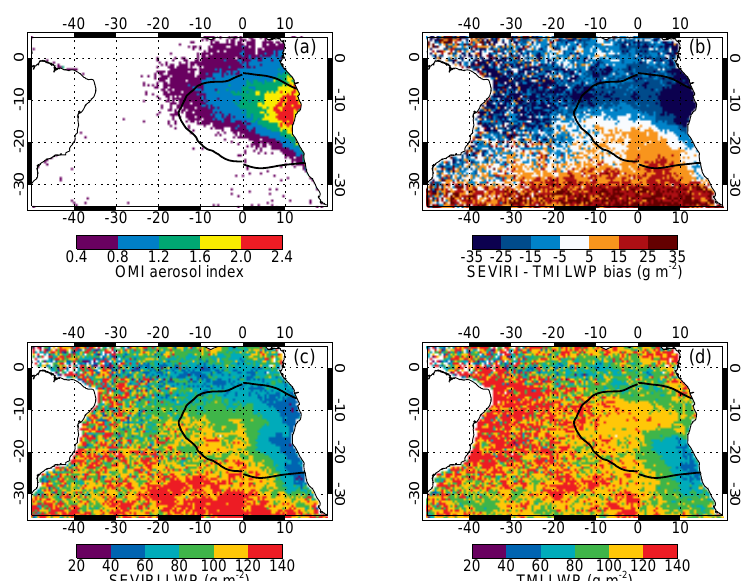
Figure 1. Spatial distribution of (a) OMI ultraviolet aerosol index, (b) SEVIRI minus TMI liquid water path bias, (c) SEVIRI liquid water path, and (d) TMI liquid water path, averaged for JAS in 2011 and 2012 for overcast (LCF ≥ 95% and τ > 3) rain- and ice-free conditions. The black contour denotes the identified stratocumulus